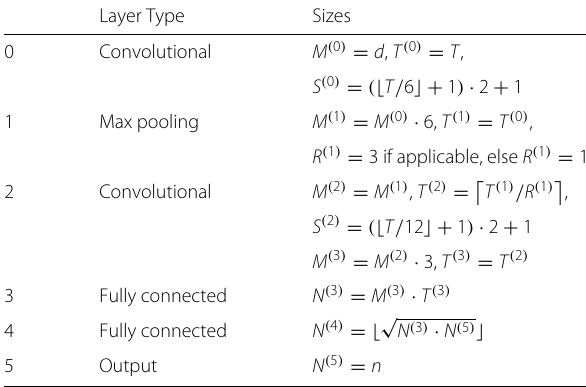
Table 1 Layers of classifier neural